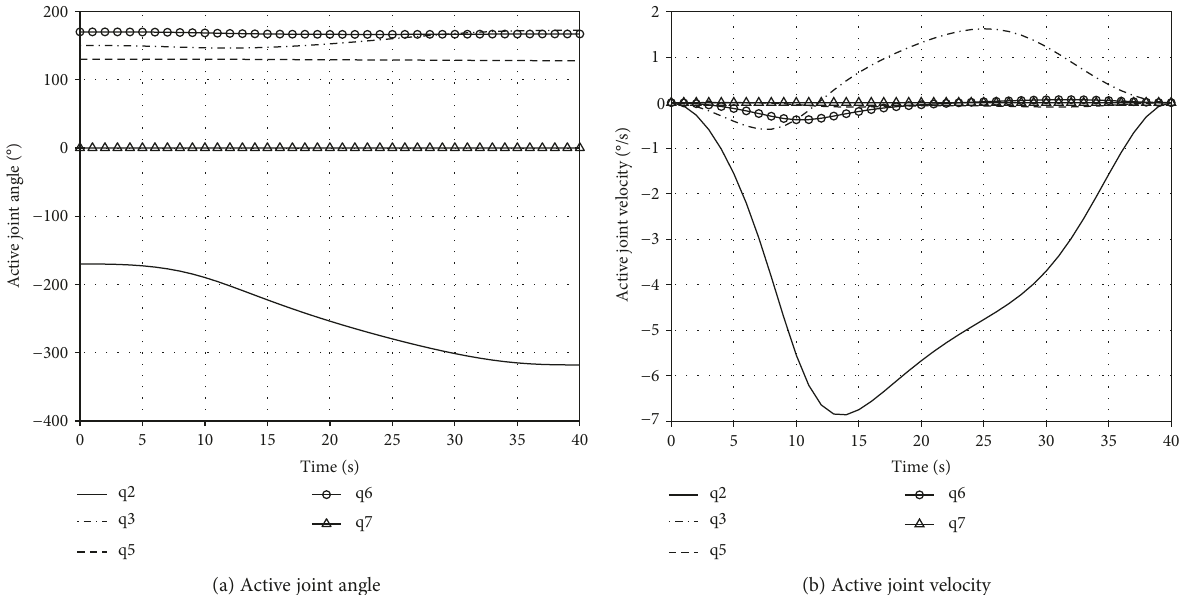
Figure 7: The variations of active joint angle and velocity with execution of the passive joint regulating task.